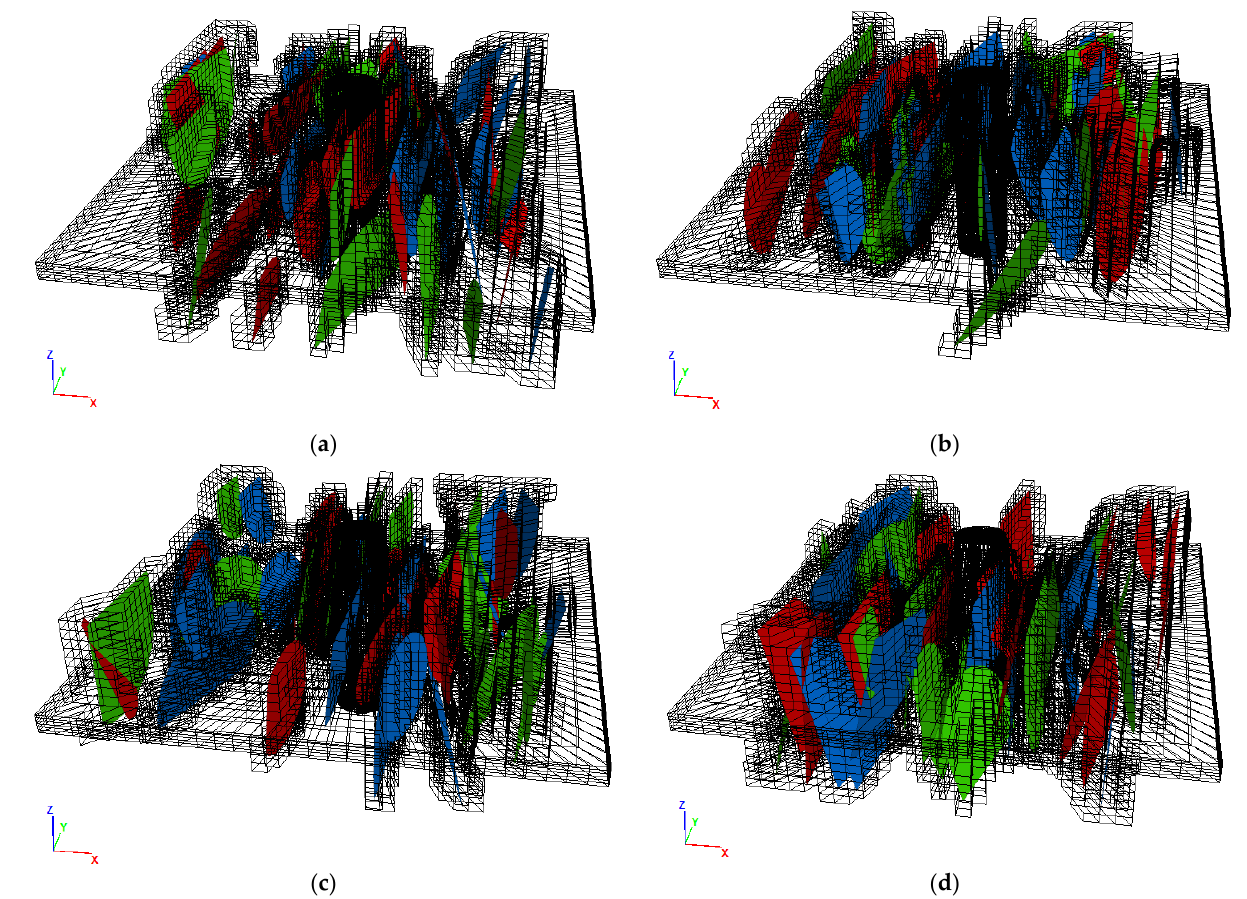
Figure 5. Discrete fracture networks and aquifers. ( a ) Aq1, ( b ) Aq2, ( c ) Aq3, ( d ) Aq4. Table 4. Model total geological parameters at different